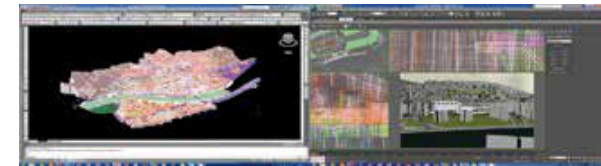
Figure 5. Graphical analysis: identification of latent geometries and plan of the 'Casa del Marinaretto'. Drawings by F. Carota.